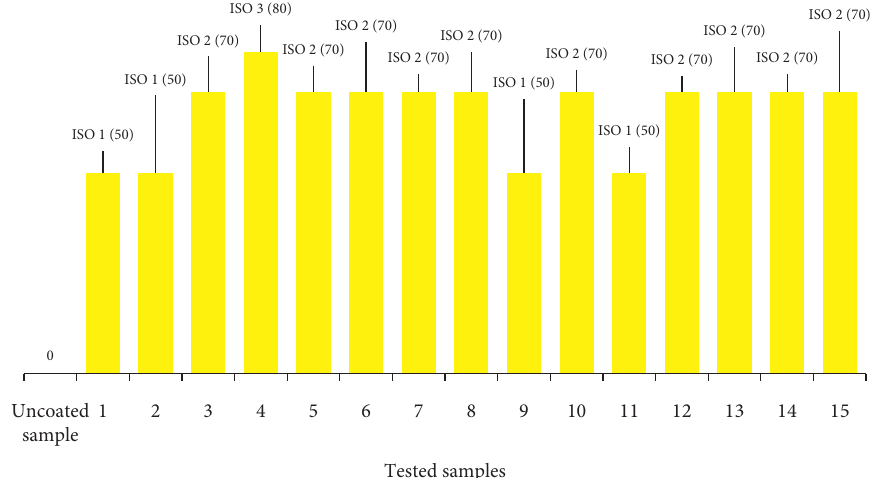
Figure 9: Uncoated and coated sample resistances in terms of surface wetting (spray